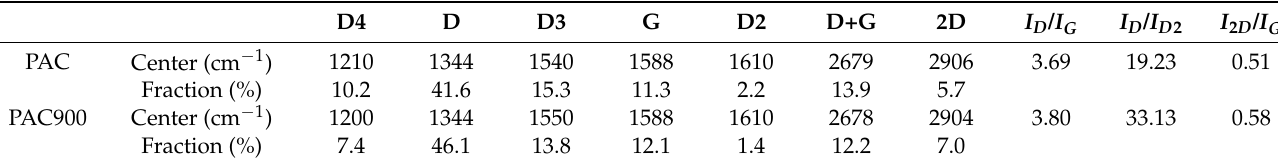
Figure 4. Raman spectra of ( A ) PAC and ( B ) PAC900. Table 2. The results of Raman spectroscopy.